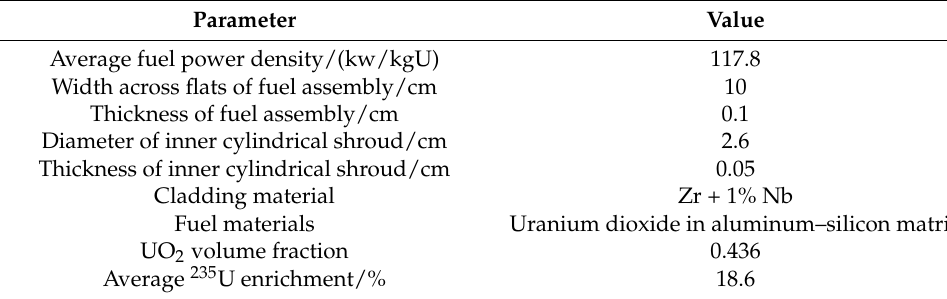
Table 1. Parameters of KLT-40S fuel assembly.